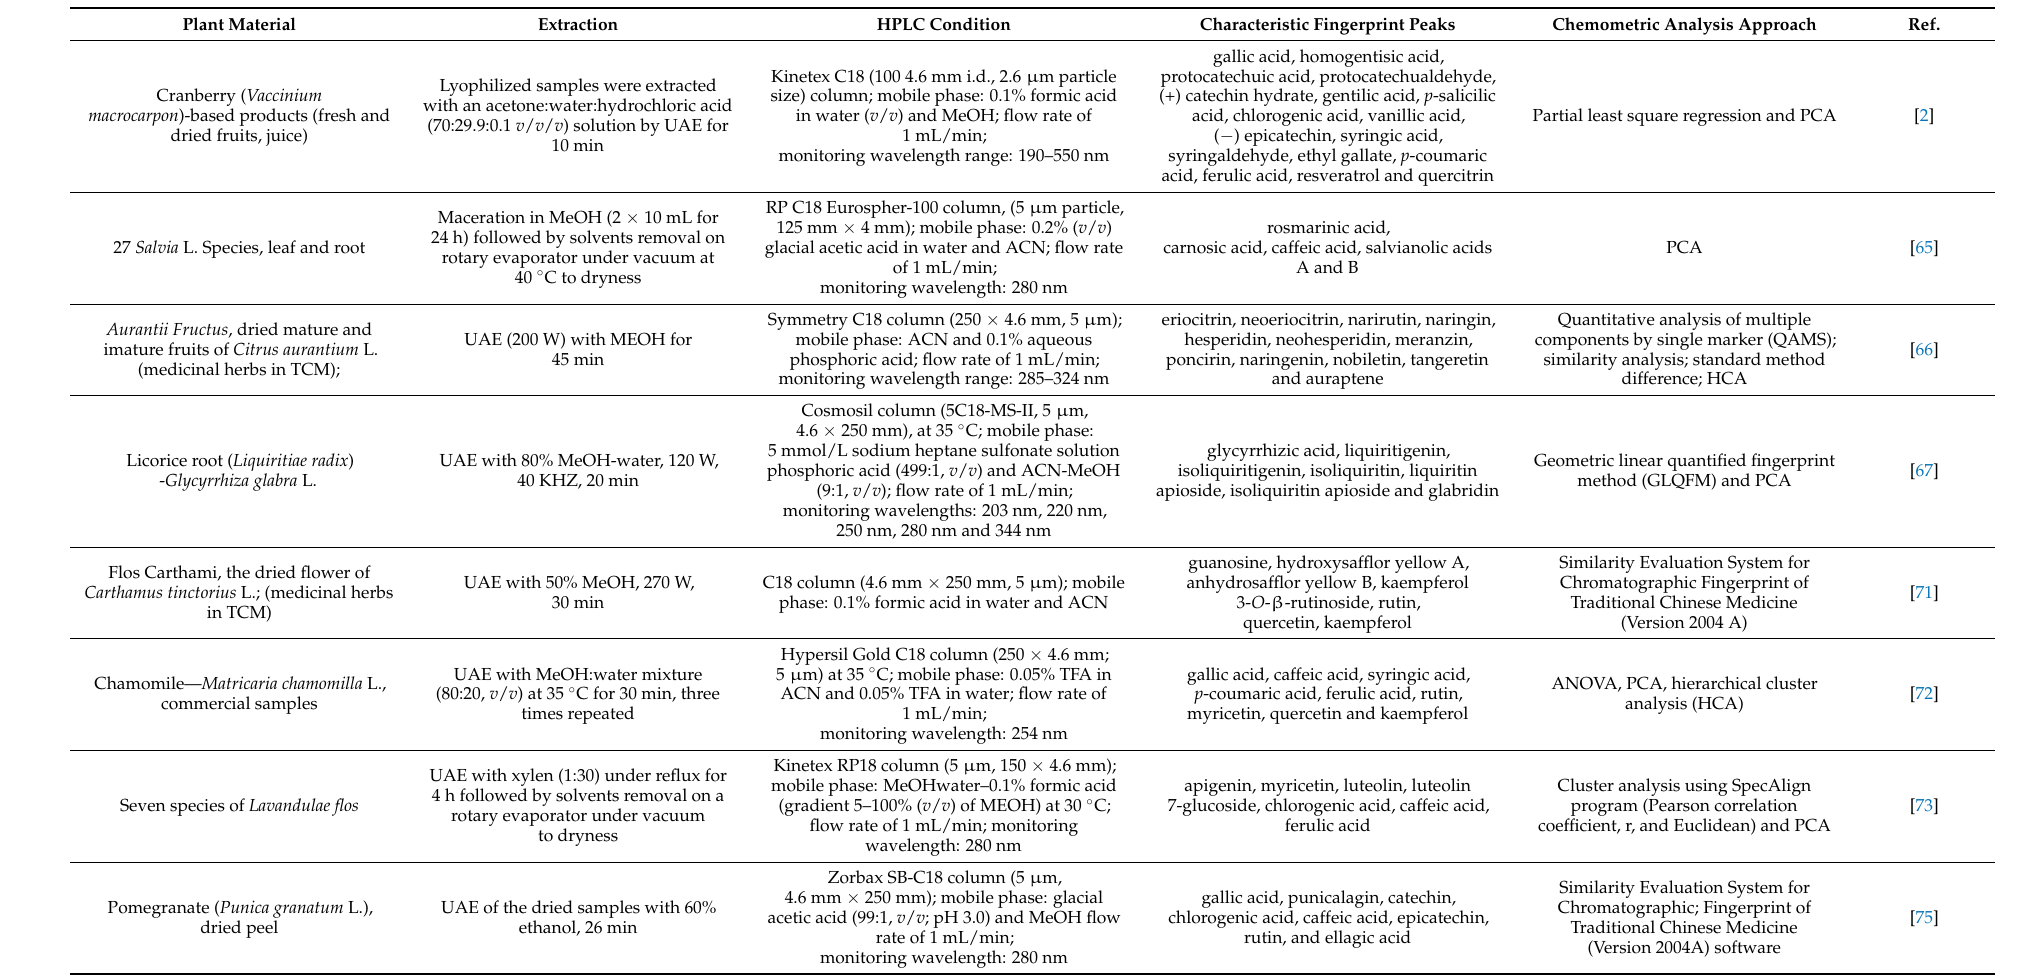
Table 1. Some examples of the recent applications of HPLC fingerprinting methods in natural polyphenols